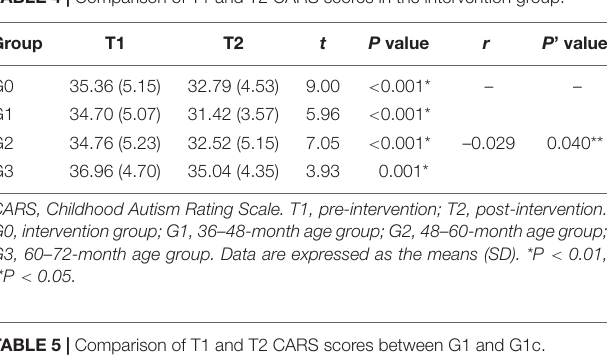
TABLE 4 | Comparison of T1 and T2 CARS scores in the intervention group.